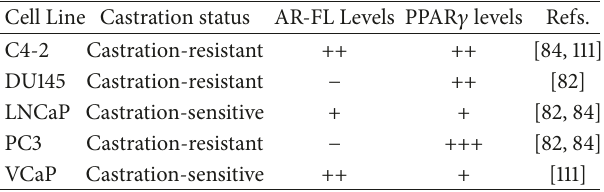
Table 1: AR-FL and PPAR 𝛾 expression within human prostate cancer cell